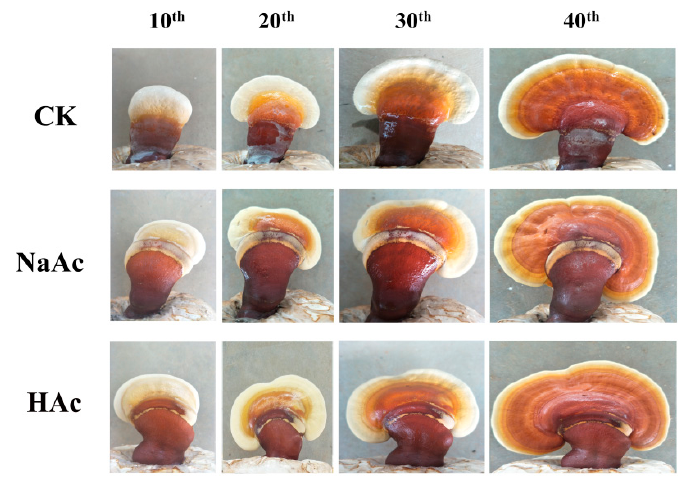
Figure 2. The morphology of fruiting bodies treated with sodium acetate and acetic acid in Ganoderma lucidum . CK, control check; NaAc, treatment with sodium acetate; HAc, treatment with acetic acid; the 10th, 20th, 30th, and 40th represent the 10th day, the 20th day, the 30th day, and the 40th day after treating.